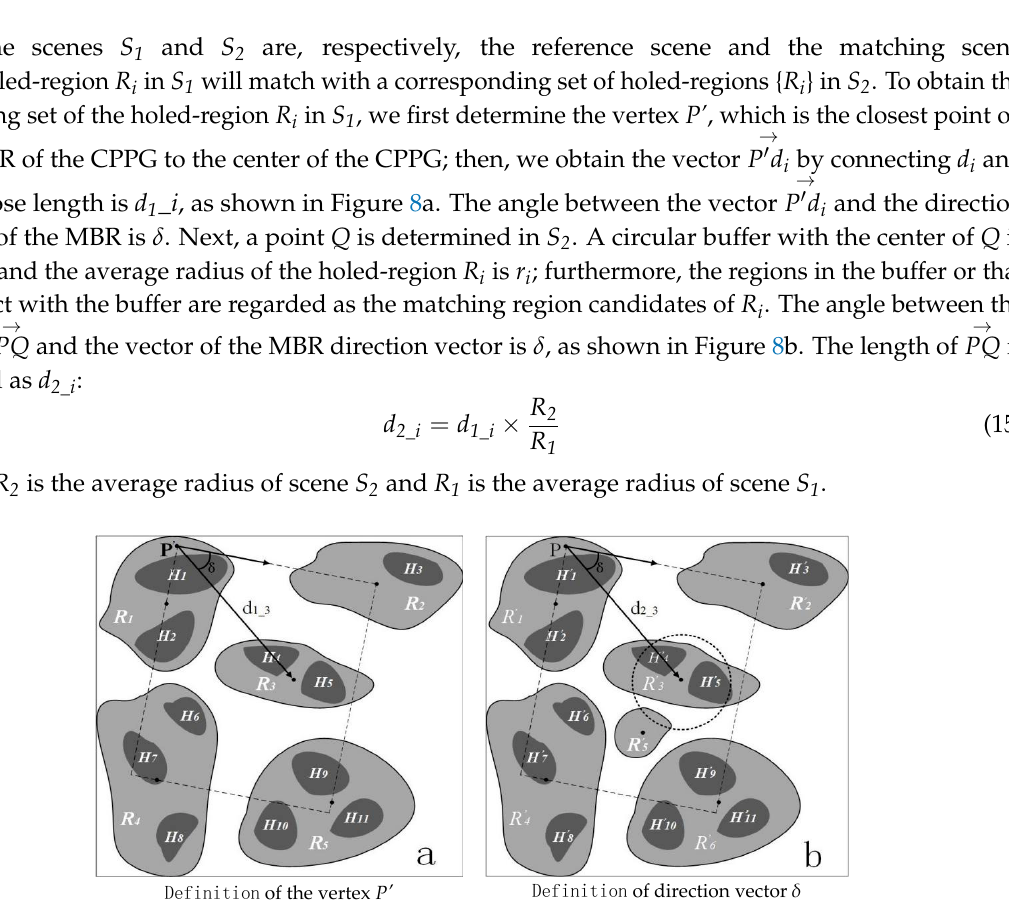
Figure 7. Complex holed-region entity scene S 2 .